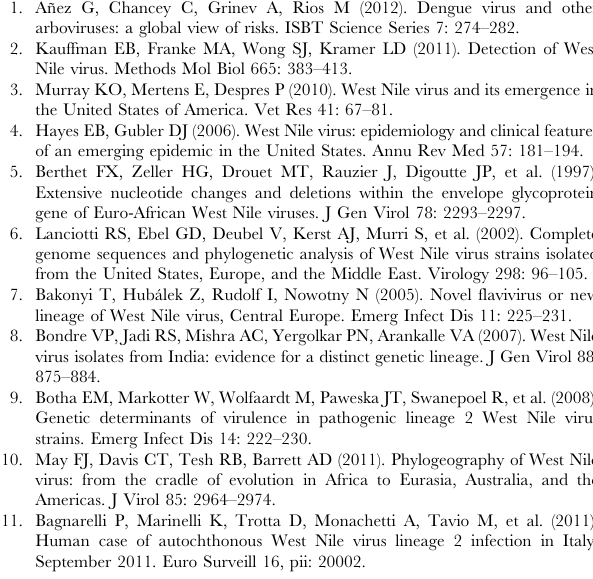
arrows. For each genotype, states shown in red in the US map are those from which strains have been sequenced and available for analysis. Table S1 List of North American WNV strains used in this study, by host, state and year of isolation. Table S2 Selection pressure acting upon codons of WNV strains collected in the US (1999–2011), ALL dataset, by host. Open Reading Frame (3,433 codons). Includes codons only detected by MEME. Table S3 Selection pressure acting upon codons of WNV strains collected in the US (1999–2011), detected by the methods employed in HyPhy (Datamonkey server). Analysis by individual gene (ALL dataset) in all ORF sequences available (n= 363). Table S4 Selection pressure acting upon codons of WNV strains collected in the US (1999–2011), detected by the methods employed in HyPhy (Datamonkey server). Analysis by individual gene in Hu-WNV isolates (n= 61). Table S5 Summary of Bayesian estimates of population dynamics of WNV infecting humans in the US ( + strain IS-98 STD, n= 62), calculated using BEAST